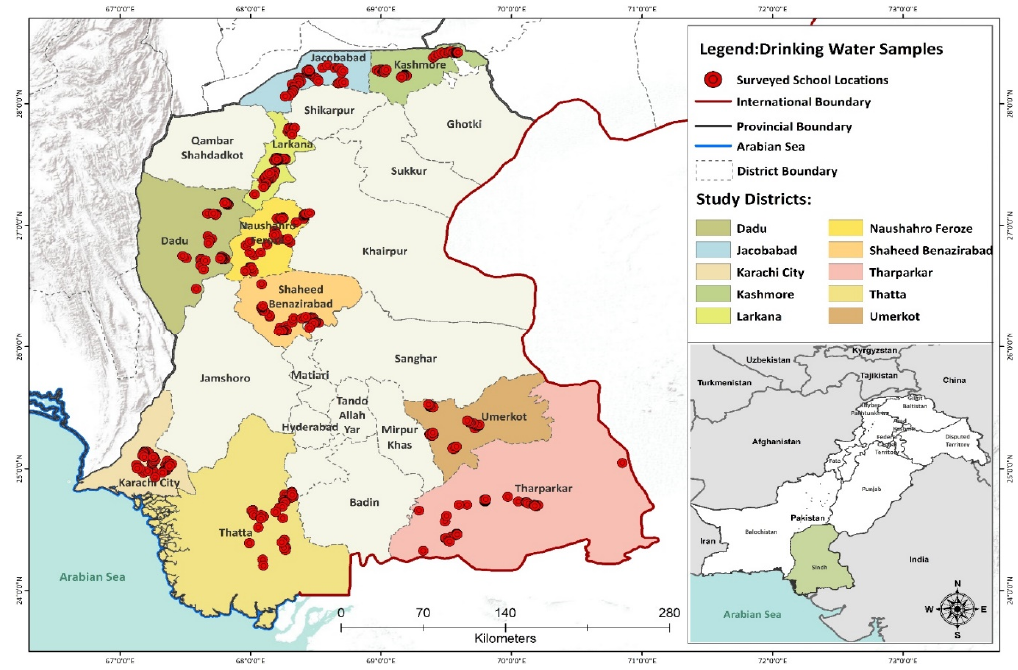
Figure 2. Surveyed schools in the Sindh province of Pakistan.